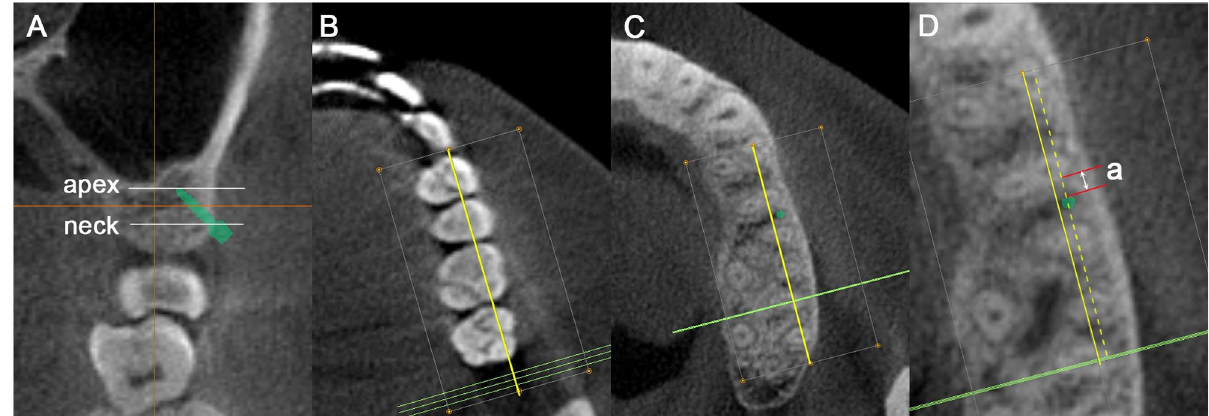
Fig 5. Measurement of miniscrew–root distance. (A) Apex and neck of the miniscrew in the coronal view. (B) Axial slice at occlusal level: yellow line, reference line connecting the buccal cusps of first and second molars. (C) Axial slice at root level: green circular dot, axial cross section of the angulated miniscrew. (D) Magnified view of (C): dotted yellow line, line parallel to the reference line; a, shortest miniscrew–root distance.